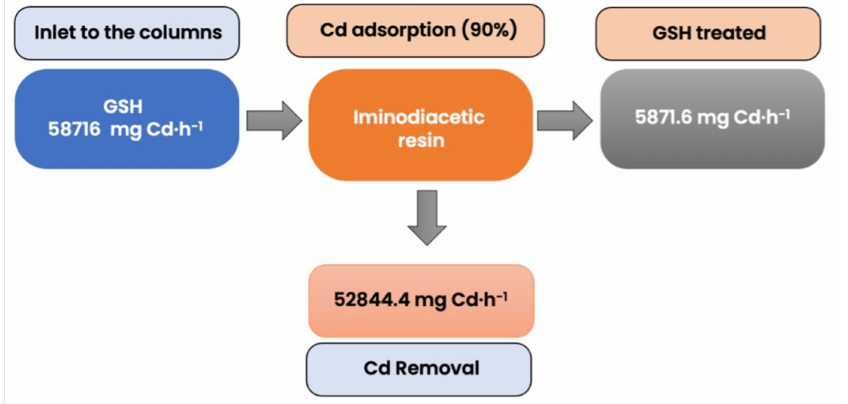
Figure 7. Representation of the mass balance of cadmium removal from GSH by columns in series with 90% cadmium removal at an industrial scale. The simulation consisted of GSH with a Cadmium concentration at the inlet of 20.97 mg L − 1 , pH of 6.20, a flow rate of GSH of 2800 L h − 1 , and a resin content of 140 kg per